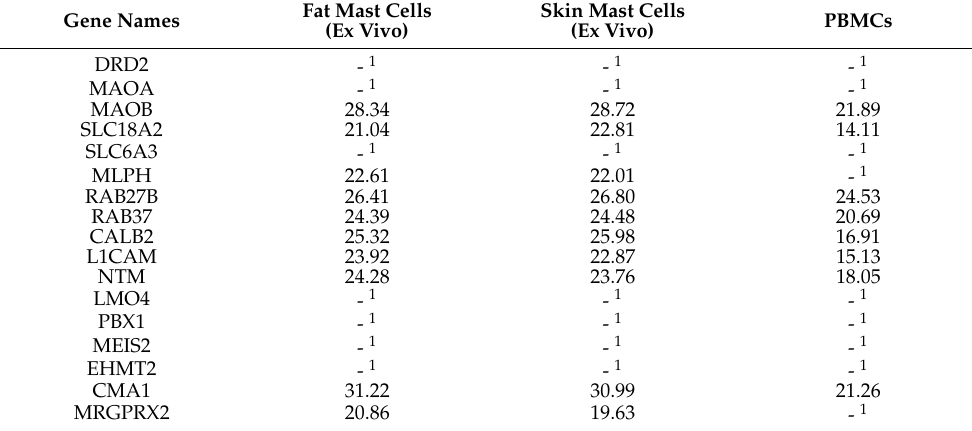
Table 2. Protein abundance of selected proteins in the proteomics study by Plum et al., 2020 [76]. In this study, the proteome of primary human (and mouse) MCs was analyzed by quantitative mass spectrometry. The MC proteome from two compartments (skin and fat tissue) was compared with that of peripheral blood mononuclear cells (PBMCs). Protein abundance was represented as log2 LFQ (Untargeted label-free quantitation) score. Higher LFQ values indicate higher expression of the mentioned protein in the indicated samples. CMA1 and MRGPRX2 are not discussed herein but were added for comparison as MC-selective entities.